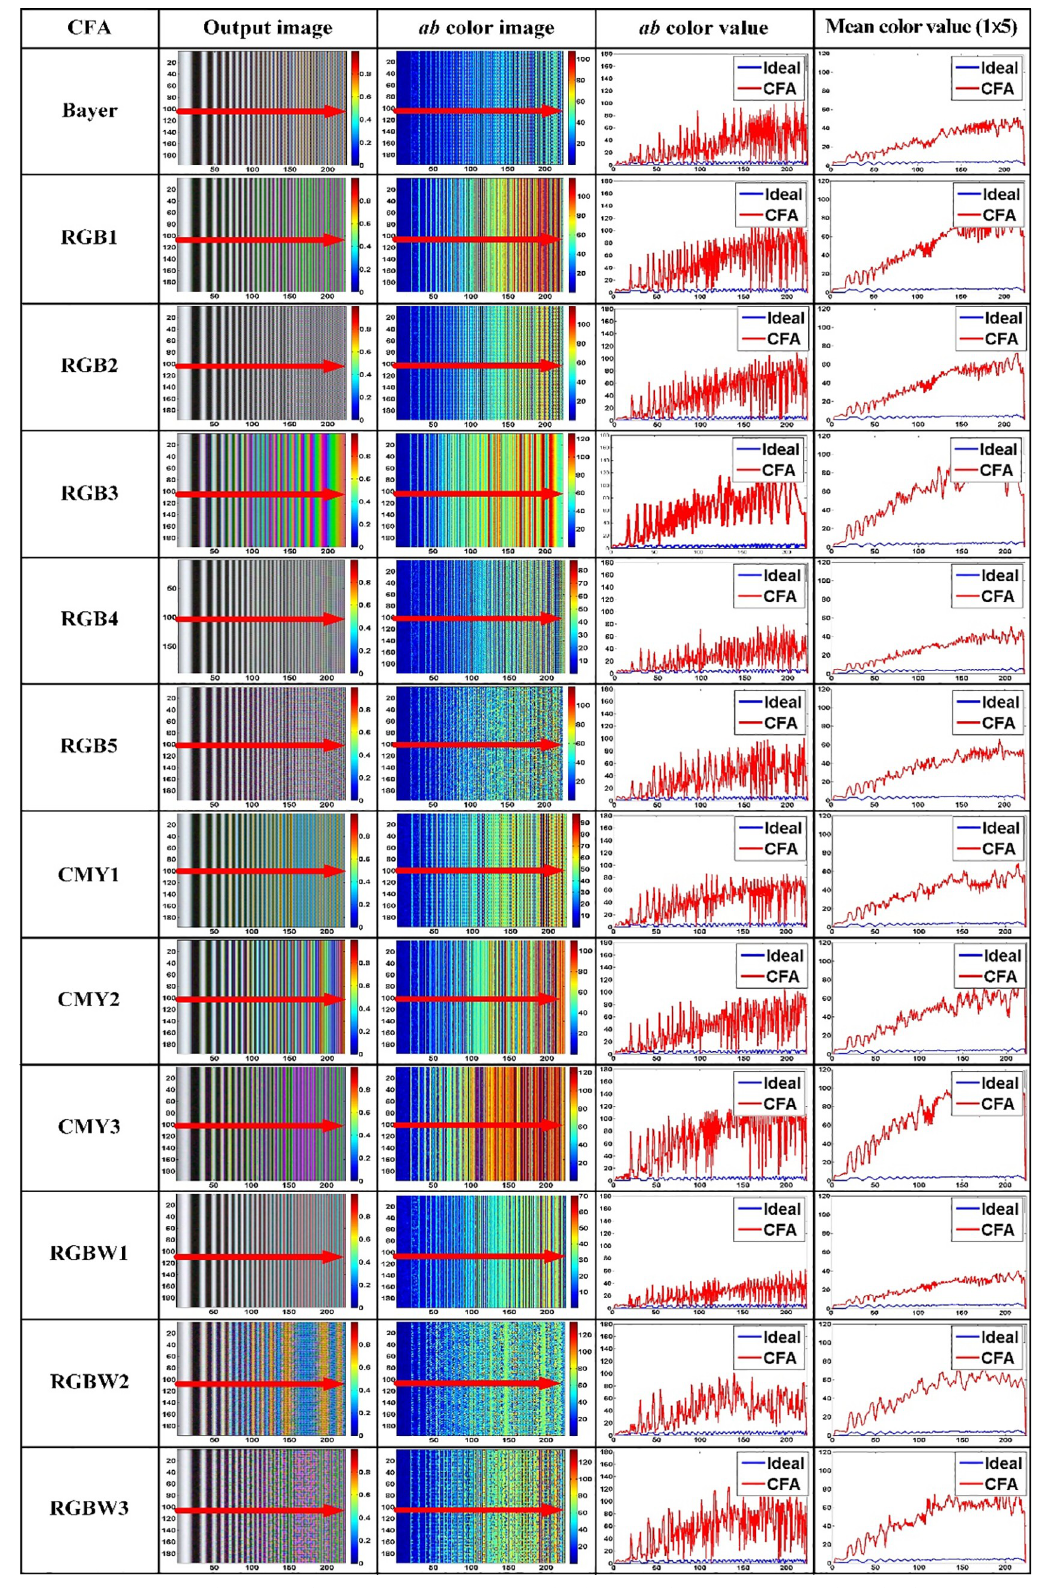
Fig 12. Output image of test CFAs for LINEAR-CHIRP image, ab color image for output image, color value for center horizontal line of color image, and filtered color value using one-dimensional (1 × 5) mean filter for the color value.